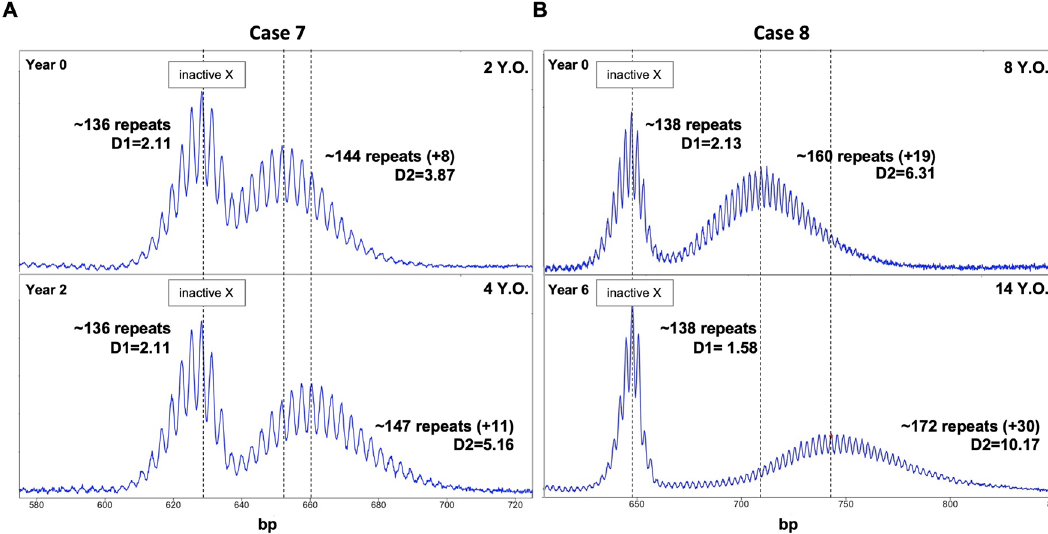
Figure 5. CE analysis shows the changes in the extent of somatic expansion over time in peripheral blood cells from two female PM carriers. The X-axis indicates the number of base pairs, and the Y-axis indicates relative fluorescence intensity.